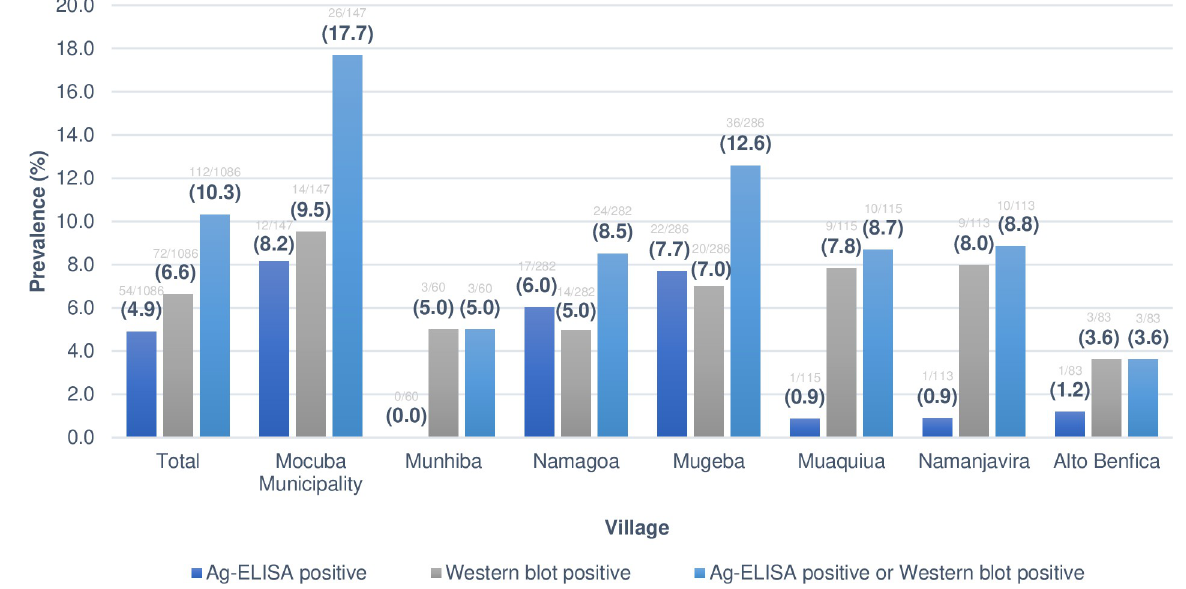
Fig 3. Prevalence of human cysticercosis according to each study village in Mocuba district.